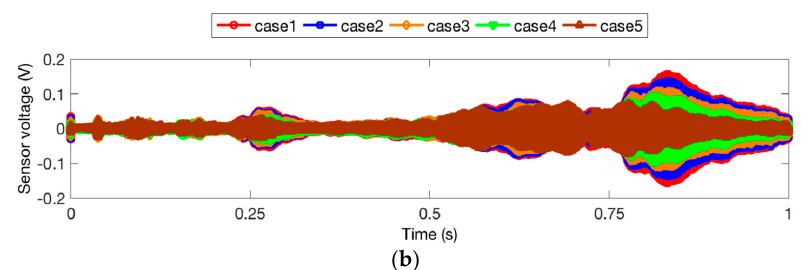
Figure 6. Sensor signal response for Group C. ( a ) Specimen 5; ( b ) Specimen 6.